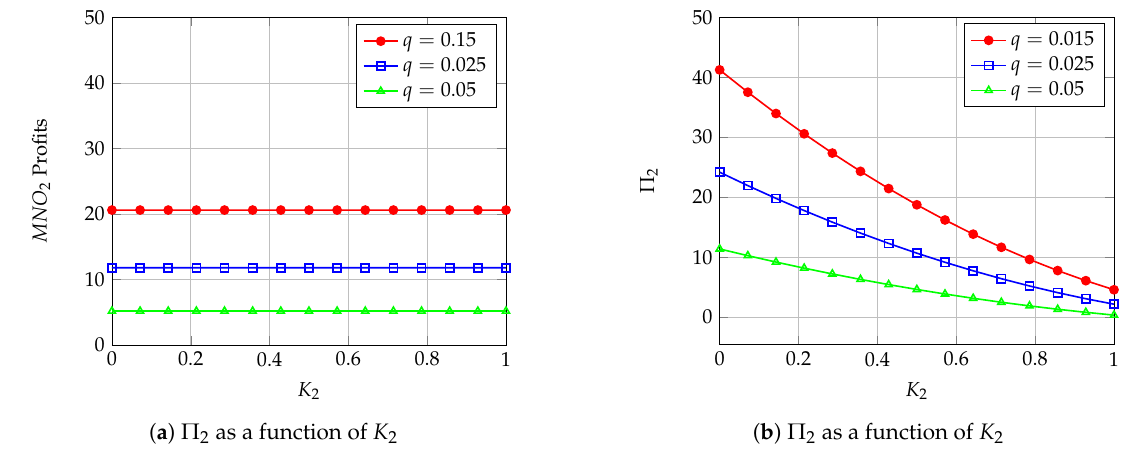
Figure A4. MNOs profits as a function of K 2 with different values of q and K 1 = 0.1, p = 0.08, c =